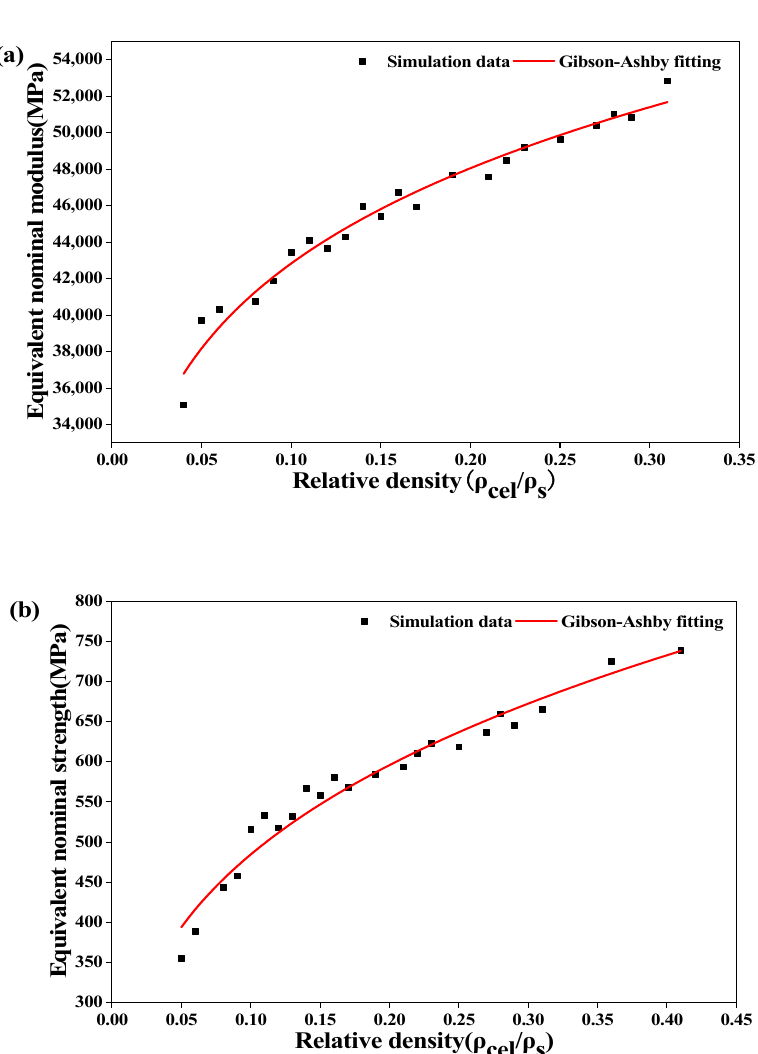
Figure 9. Variations in ( a ) equivalent nominal modulus and ( b ) equivalent nominal strength of the D structure with relative density.